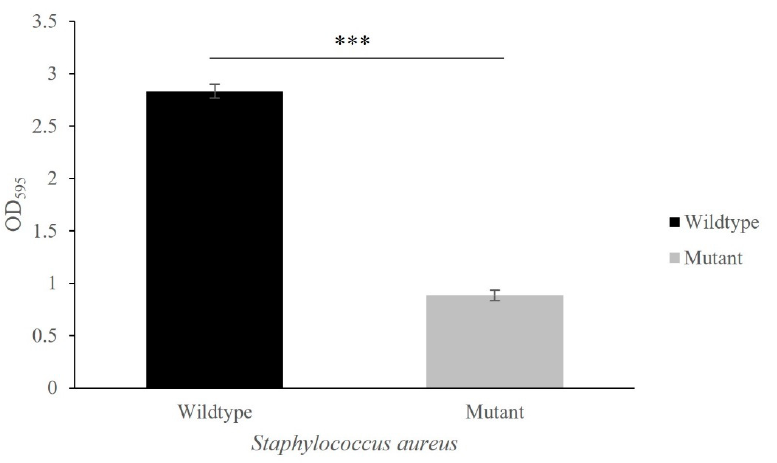
Figure 4. Decreased biofilm formation in isaA mutant compared to wildtype. Quantification of biofilm formation was based on the crystal violet retained by bacterial biofilm. *** p ≤ 0.001.